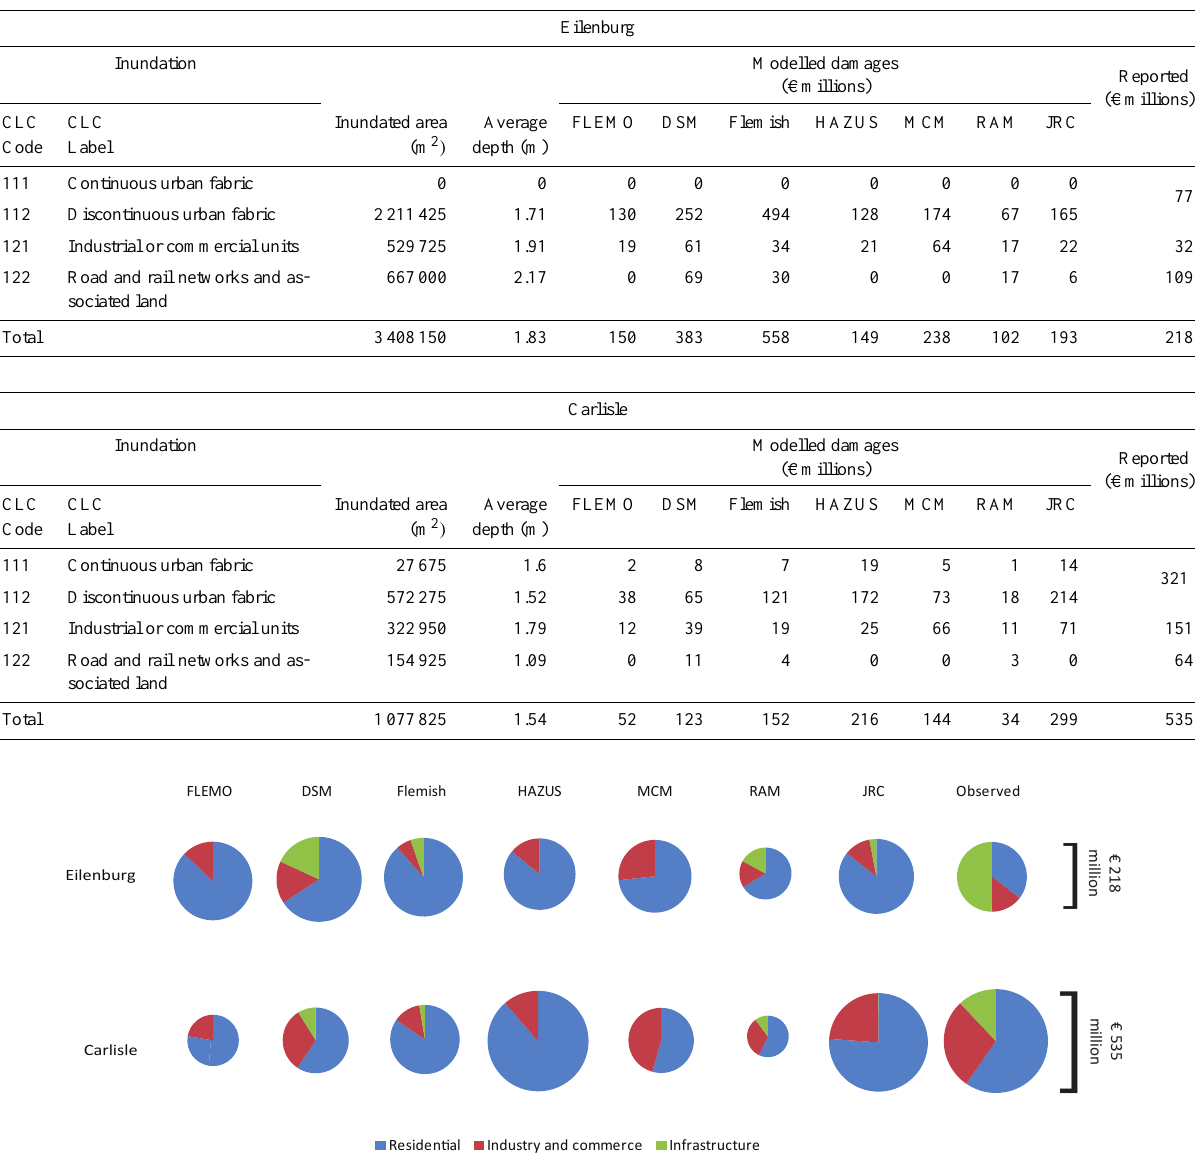
Table 4. Results of the model runs for Carlisle and Eilenburg, with the inundation details on the left and the modelled and reported damages on the right. Further elaboration on the adjustment of damage model classes and reported damage data to the CORINE land use classes is provided in Sects. 3.2.1 and 3.2.2.